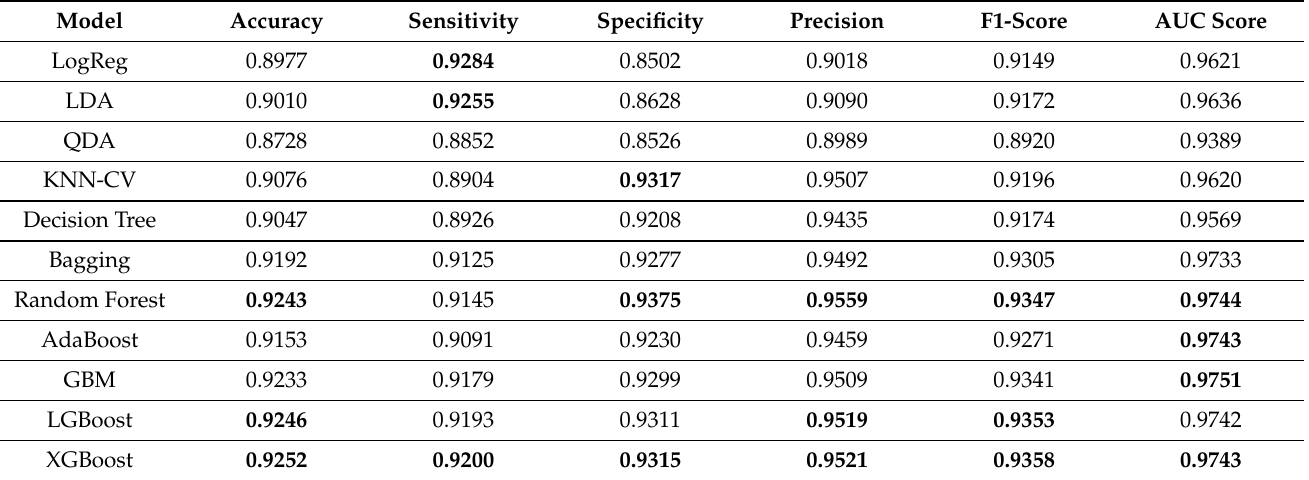
Table 3. Results for all models with 5-s segmentation scheme using LOOCV. Top three results are highlighted for each